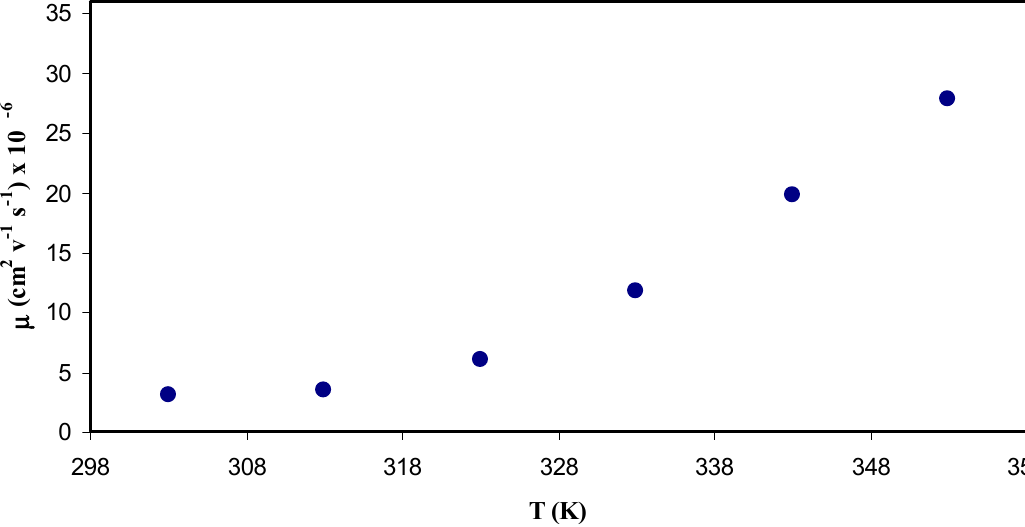
Figure 15. Ion mobility µ as a function of temperature ( T ). It is obvious that the mobility of ions increases nonlinearly with temperature.